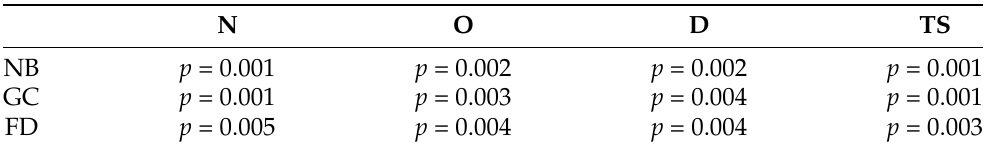
Table 1. The Wilcoxon rank sum test confidence scores between Pre and Post states for the different subcategories of the SSQ test (N—Nausea; O—Oculomotor; D—Disorientation; TS—Total Score);